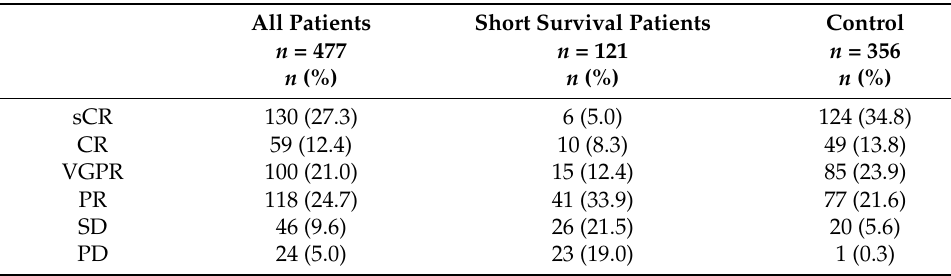
Table 2. Best response rate of MM patients.